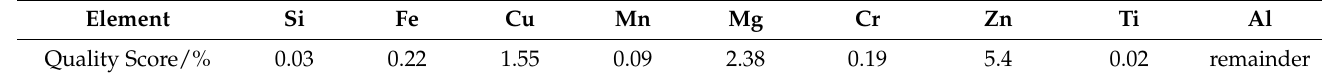
Table 1. Chemical composition of Al7075-T6.